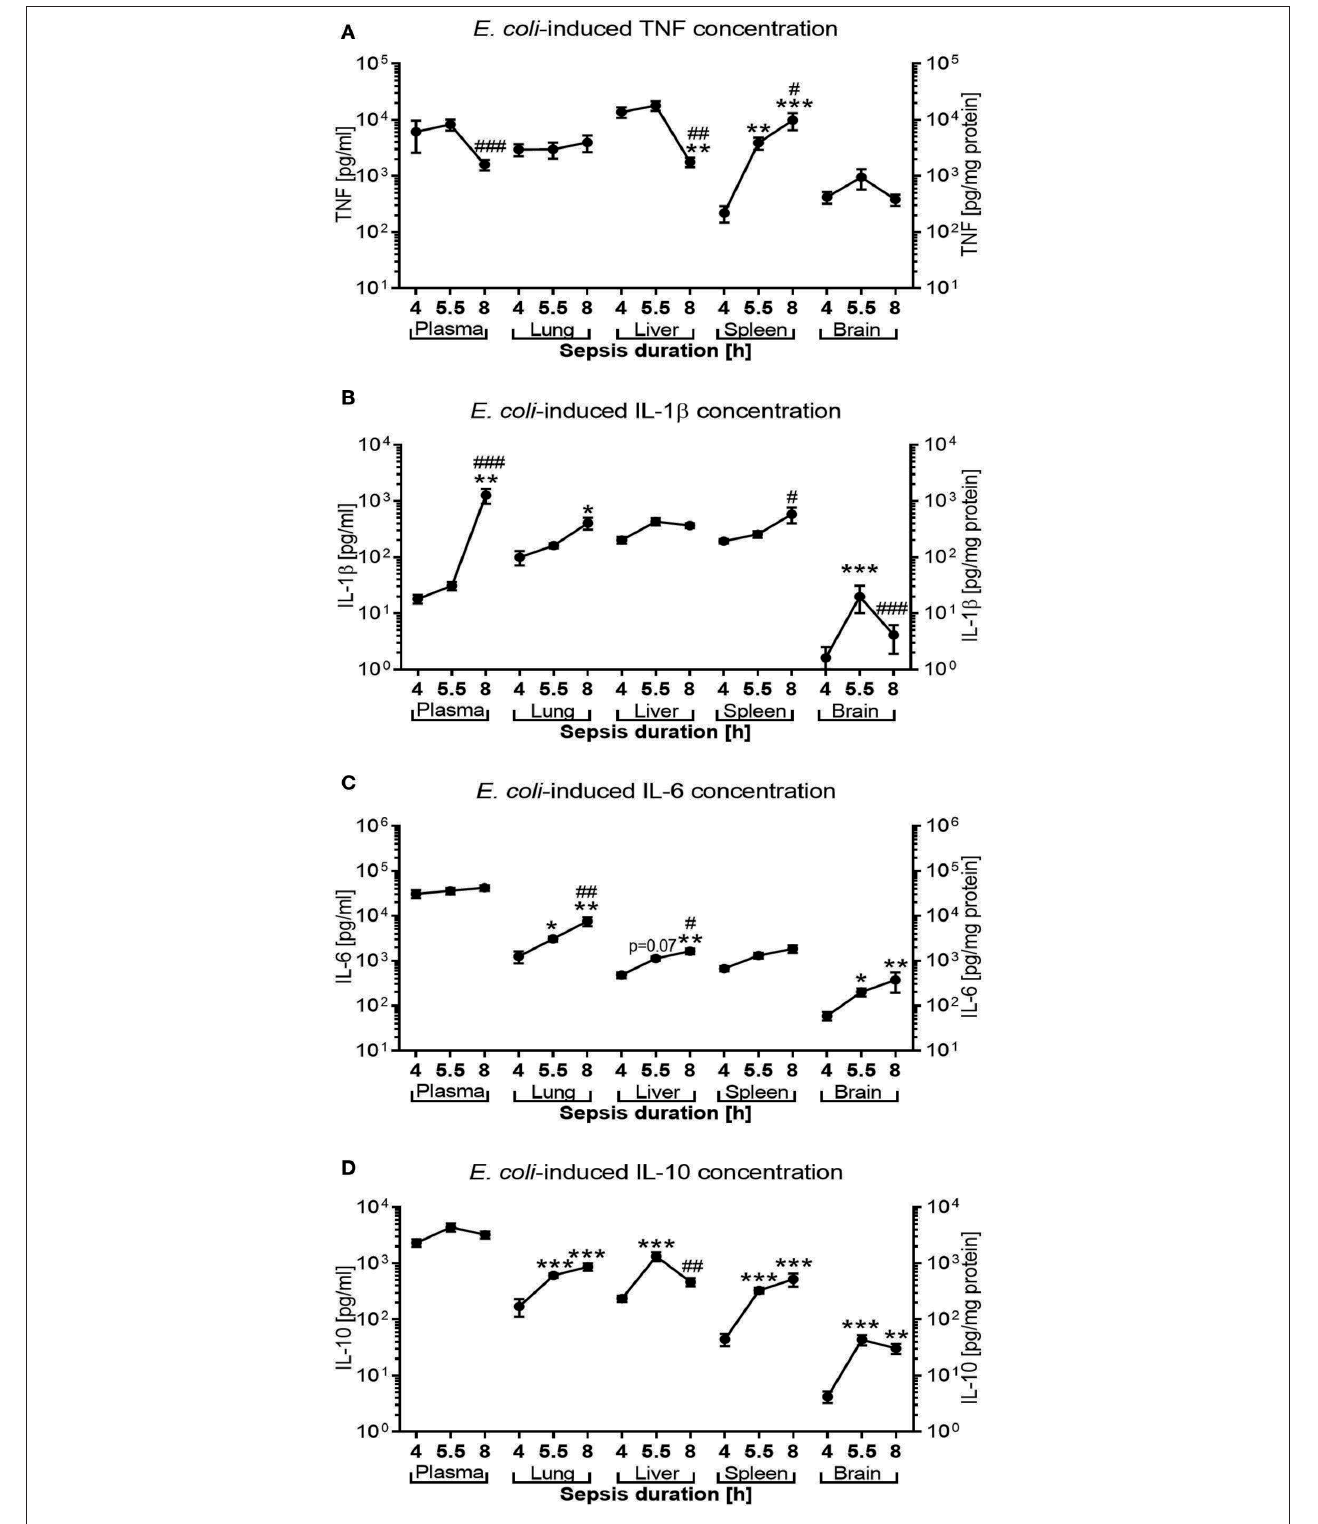
FIGURE 8 | E. coli -induced cytokine production in neonatal mice as a function of sepsis duration. Neonatal mice < 24h old were injected IV with E. coli 10 5 CFU/g body weight. After 4h ( n = 8), 5.5h ( n = 34), and 8h ( n = 18) of incubation, mice were euthanized, and pro- and anti-inflammatory cytokines were measured in plasma and homogenized organ tissue. Mean ( ± SEM) or median (IQR) concentrations for (A) TNF, (B) IL-1 β , (C) IL-6, and (D) IL-10 were plotted for each time point